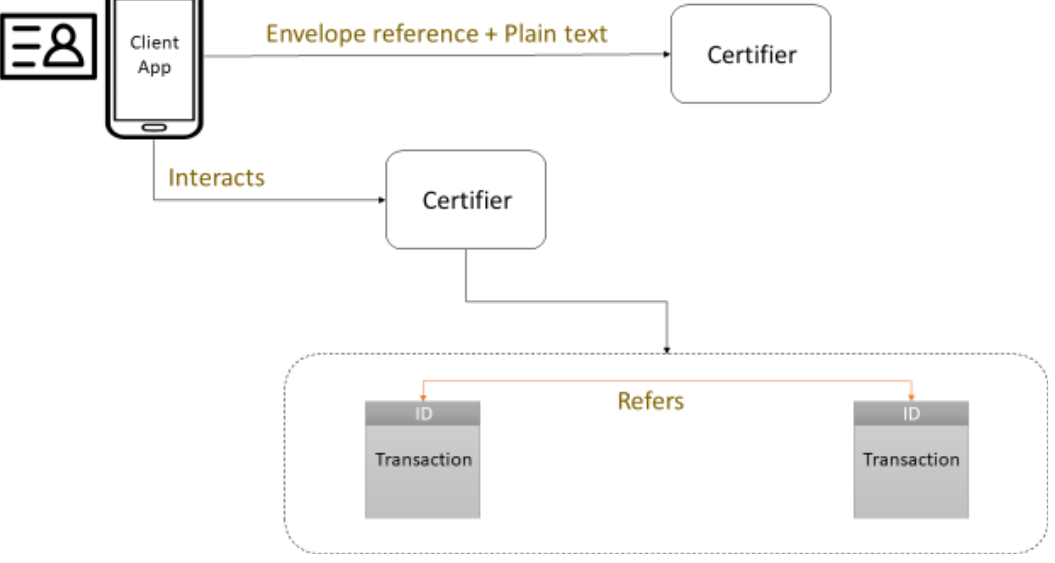
Figure 4. The architecture of